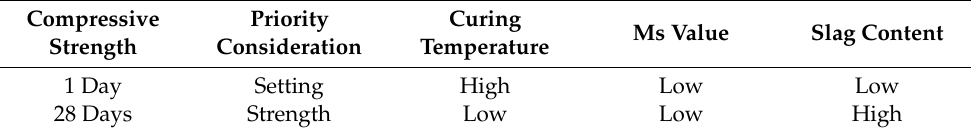
Table 6. Comparative experimental variables enabling maximisation of compressive